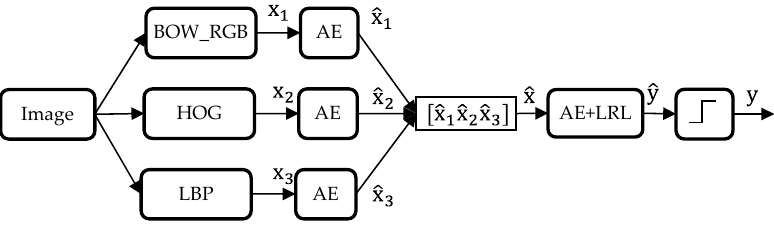
Figure 5. Diagram of the second fusion strategy (Fusion 2) based on a AE induced-level aggregation.